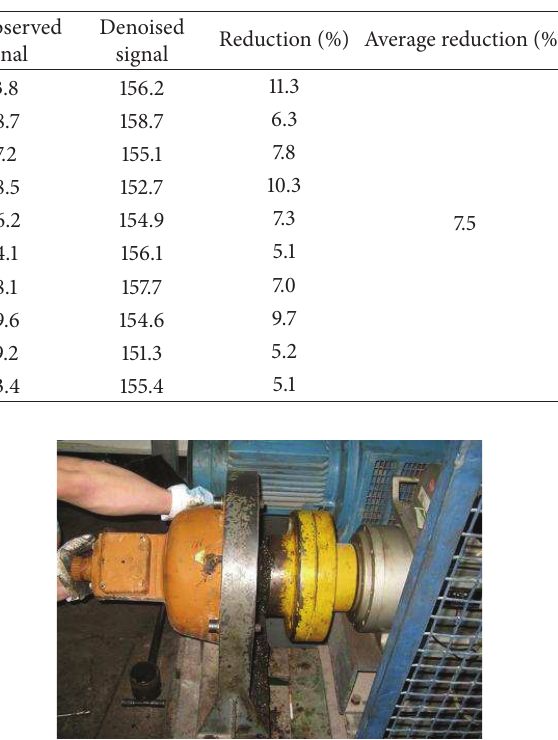
and the pin cannot be reset but the centrifugal governor must be reset after each detecting. This measurement process repeated for 3 times until the maximum detected catching torque reaches or exceeds the computed torque. After 3 measurements, the nut and the pin are reset